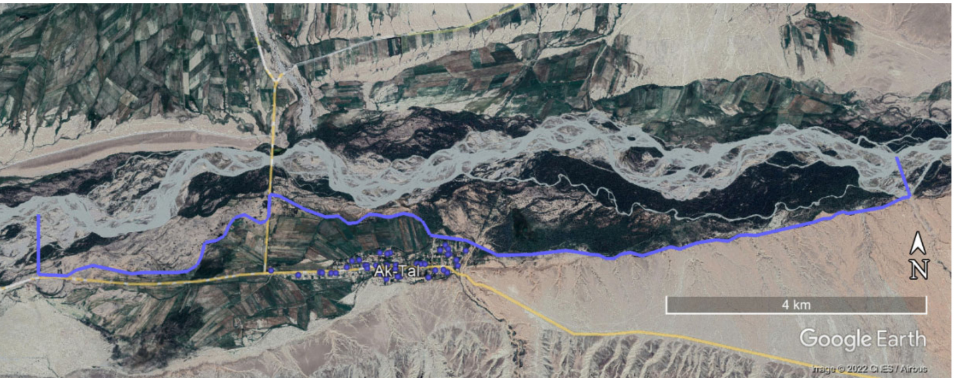
Figure 3. Ak-Tal Village upon the Naryn River, its attributed riparian forest area (blue line), and the 40 survey locations of the Ak-Tal Household Survey 2020 (blue